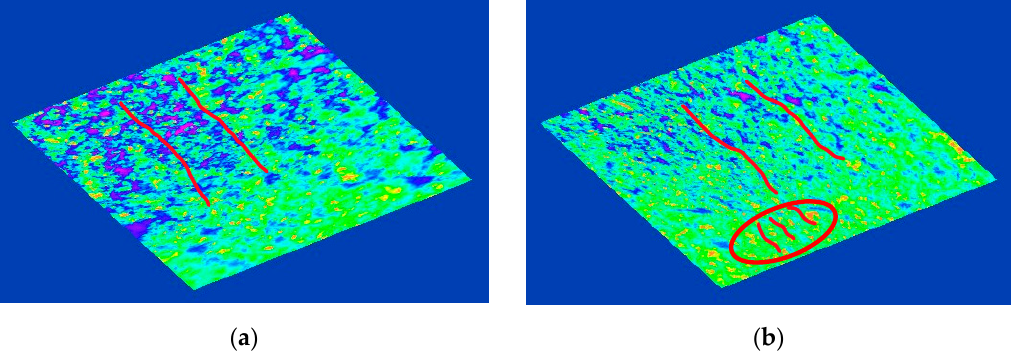
Figure 8. Agglomeration areas formation in course of MAE polymerization with atomized powdered iron filler in an external magnetic field: ( a ) 50%; ( b ) 70%.